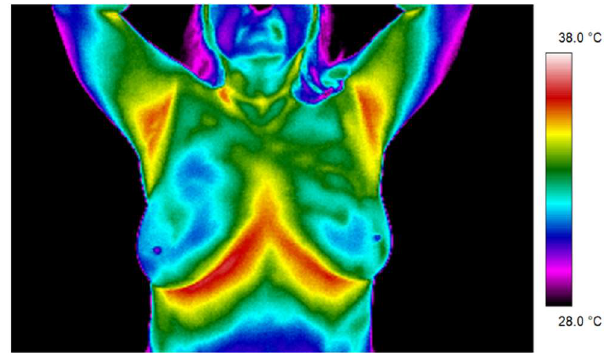
Figure 4 . The exemplary thermogram for healthy women. Figure 4. The exemplary thermogram for healthy women.